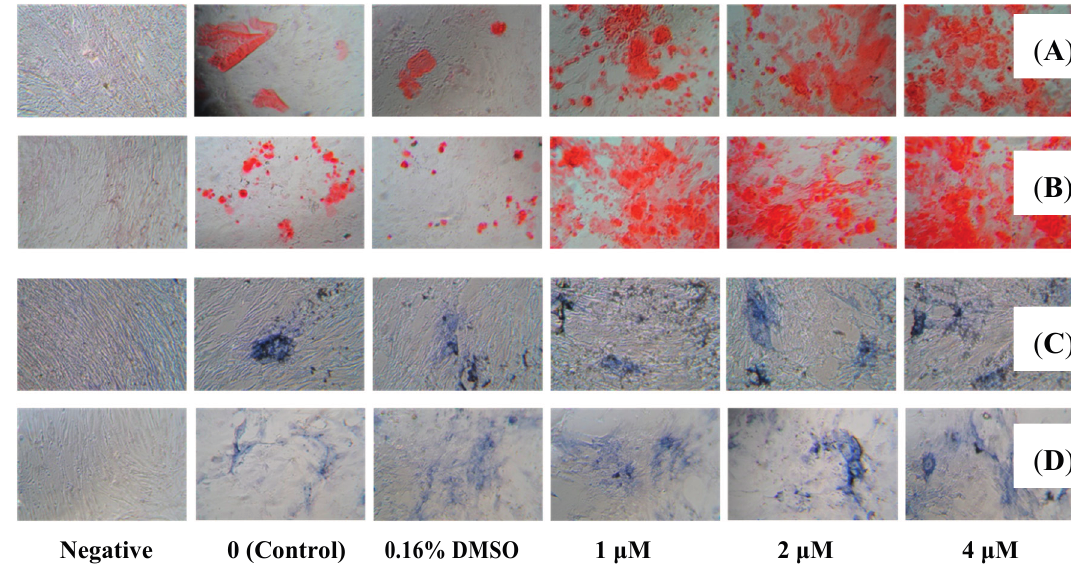
Figure 3. Detection of extracellular calcium deposits and membrane alkaline phosphatase (AP) activity in differentiated osteoblasts. Alizarin red S staining after inducing for osteogenic differentiation for 14 days ( A ) and 17 days ( B ) showed time and dose-dependent increases in calcium deposits (red color) in hMSC treated with compound 1 , indicating enhanced osteoblast formation. 5-Bromo-4-chloro-3-indolyl phosphate/Nitro blue tetrazolium (BCIP/NBT) staining (cell AP activity staining kit) (( C ) 14 days; ( D ) 17 days) exhibited much more blue-violet color in hMSC treated with 1 than that in control or cells treated with 0.16% DMSO, inferring elevated cellular AP activity in osteoblasts.